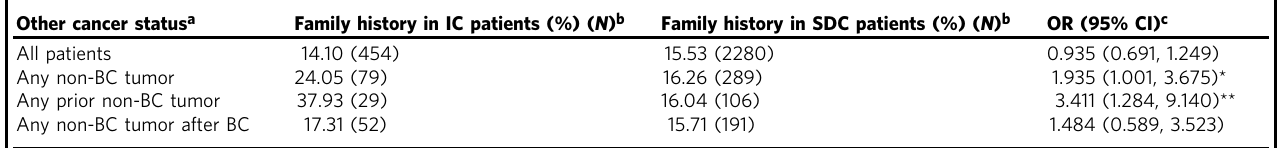
Table 2 Association of non-BC family history with interval breast cancer Other cancer status